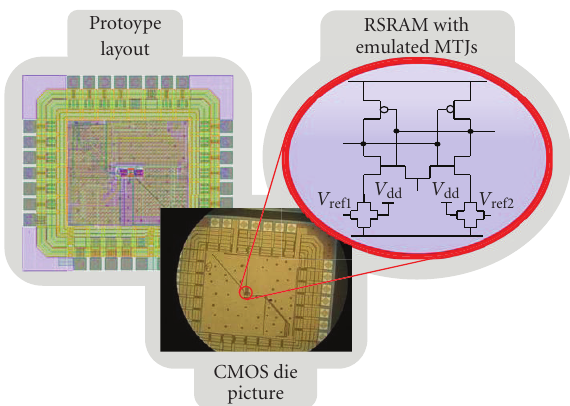
Figure 10: First test chip realized: layout (left), picture (center), emulated MTJ RSRAM cell schematic (right).